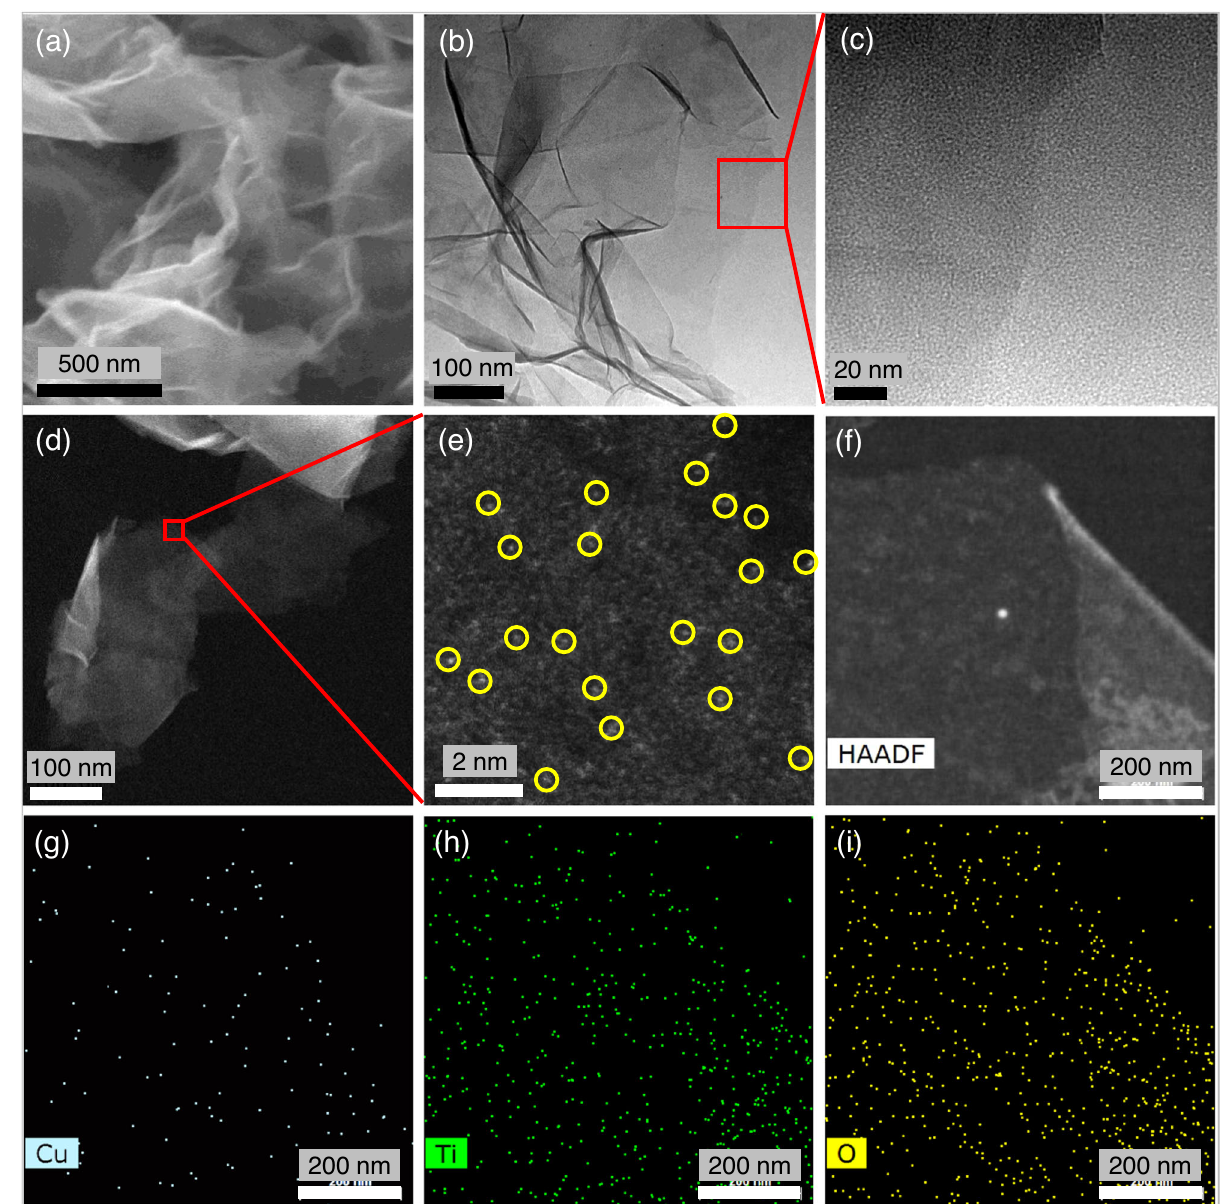
Fig. 1 | Morphological and structural characterization of Cu-Ti-V O /Ti 0.91 O 2 -SL. a FE-SEM and b , c TEM images, d , e AC HAADF-STEM images, and f – i EDS